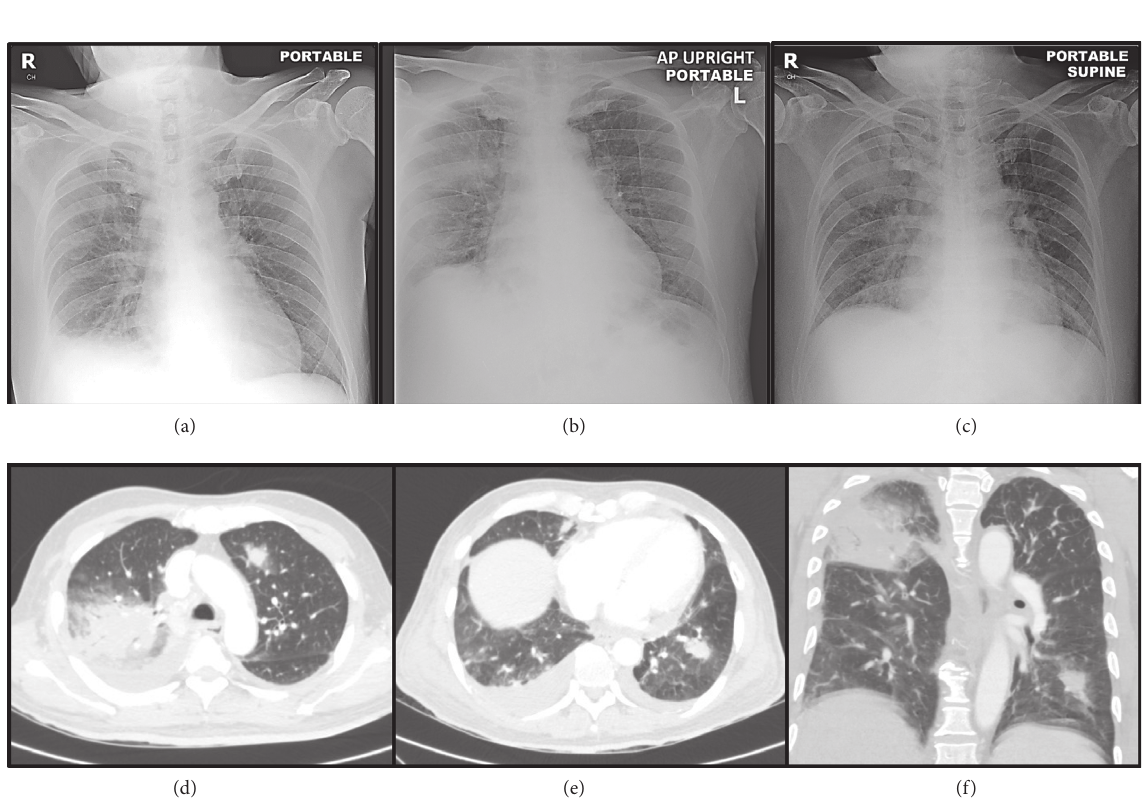
Figure 1: Images in a 58-year-old male patient with acute myeloid leukemia who had positive chest symptoms. (A) Baseline chest film shows right lower lung opacity. (B) Chest film on first day of febrile neutropenia (ANC � 0 μ L) shows new opacity at right upper lung and left retrocardiac region. (C) Chest film on the fifth day of febrile neutropenia (ANC � 624 μ L) shows stable opacities at right upper and left lower lungs. (D–F) Axial and coronal CTchest on third day of febrile neutropenia (ANC � 432 μ L) reveals pulmonary consolidation at right upper lobe and a nodular lesion at left lower lobe. Both lesions are surrounded by a halo of ground-glass attenuation, suggesting angioinvasive pulmonary aspergillosis. This case was evaluated as true-positive chest radiograph and CT